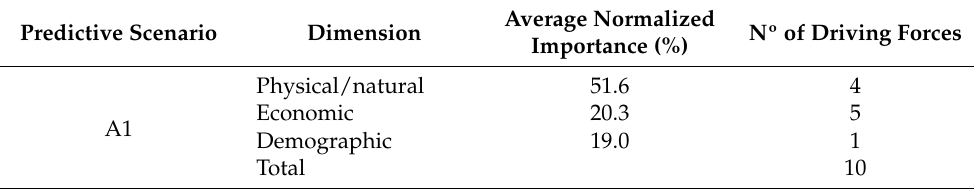
Table 10 introduces the normalized importance average per analysis dimension of the ten first driving forces for each scenario. Table 10. Statistics per analysis dimension of normalized importance of the ten first driving forces in LULC dynamics for the predictive scenarios